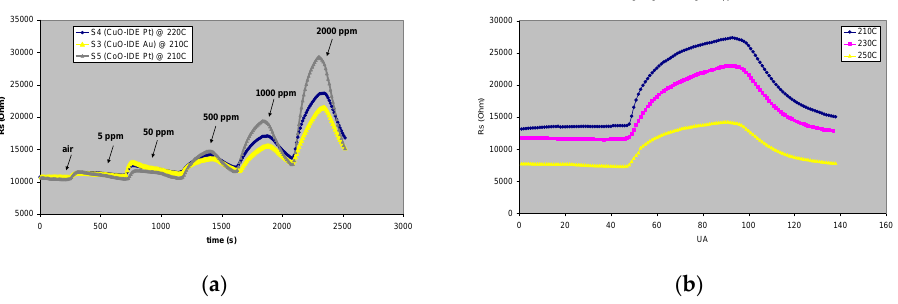
Figure 3. ( a ) The response/recovery of the tested sensors for CH 4 concentrations in the range of 5–2000 ppm at T w specific to the investigated sensors (210–220 °C); ( b ) response/recovery of the S5 sensor for 2000 ppm CH 4 at various working temperatures (T w ).